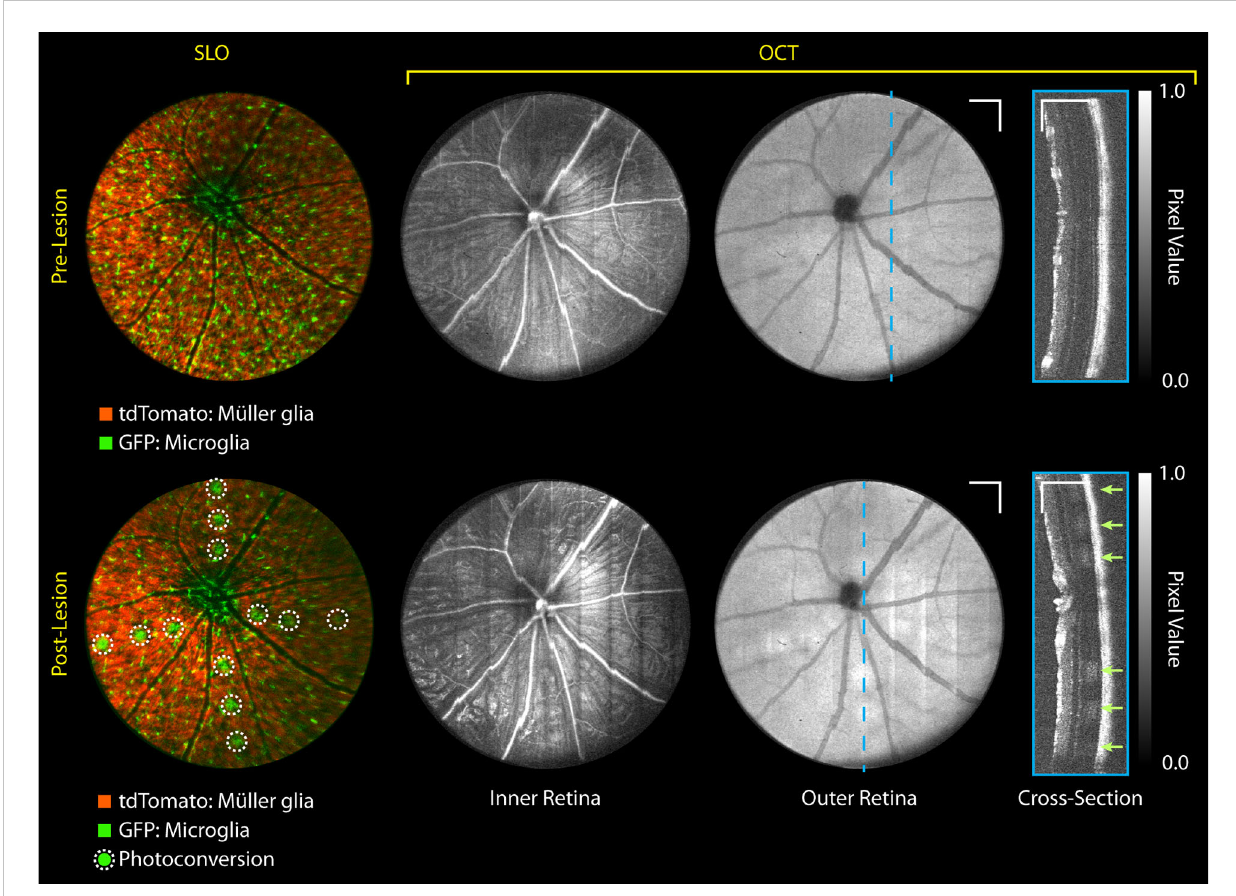
FIGURE 5 MURIN retinal imaging pre- and immediately post-laser lesioning. 3 lesions were placed in each of the 4 quadrants (nasal, temporal, superior, inferior) with a single 6 mW 200 ms duration laser pulse (arrows). These low-severity lesions show small increases in OCT scattering only on outer retinal projections and depth cross-sections, but SLO shows high-contrast fl uorescence photoconversion of tdTomato. Grayscale contrast in both OCT volumes were matched using speckle background to visualize relative scattering increases at the lesion. Intensity non-uniformity in OCT inner retinal projects is a volume projection artifact and does not re fl ect differences in image quality across the FOV. Scale bar: 250 µm. Colorbar: Normalized pixel intensity